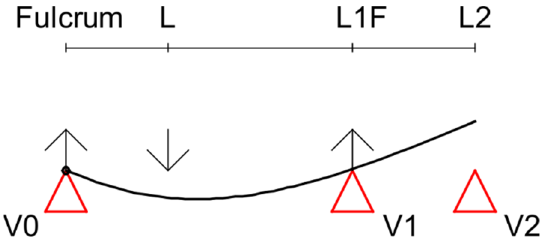
Figure A6. Representation of the effect superimposition analysis on the hyperstatic beam.